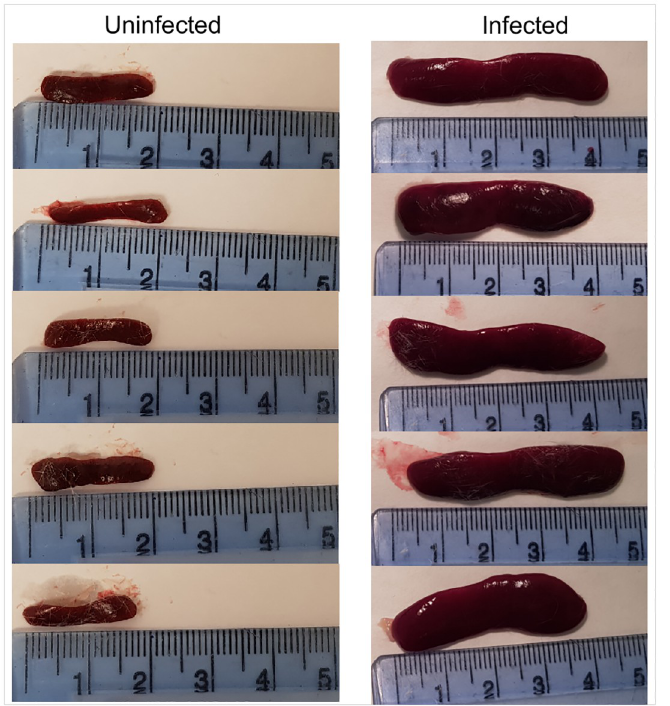
Fig 4. Infected and control group spleens. Spleens were taken at the end of the experiment on day 28 pi, weighed and photographed. A clear difference can be seen between the infected and control spleens, with the infected spleens appearing swollen and approximately double the length of the uninfected